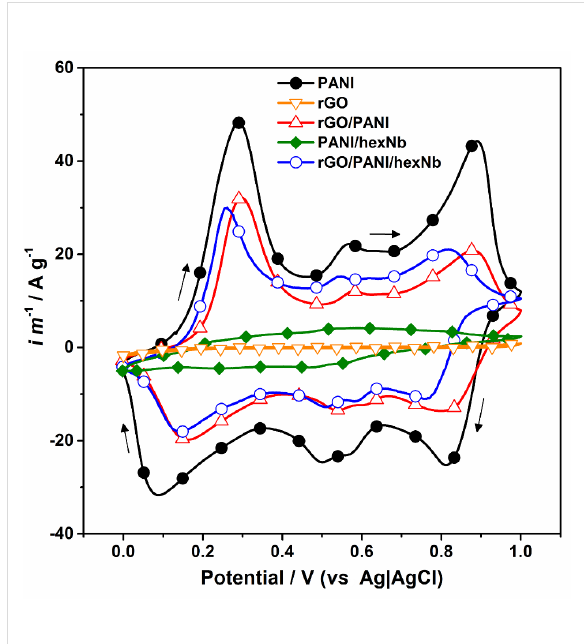
Figure 7: CV curves of PANI, rGO, rGO/PANI , PANI/hexNb and rGO/ PANI/hexNb at 25 mV·s − 1 scan rate. Electrolyte solution: 1 mol·L − 1 sulfuric